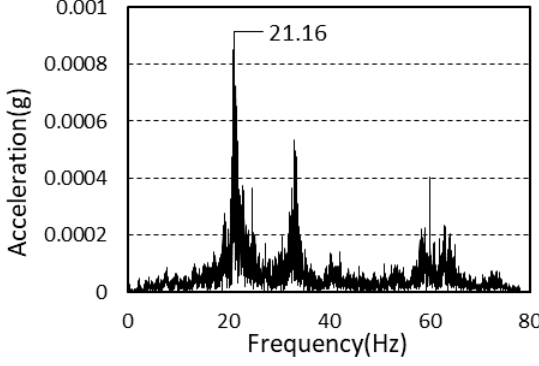
Figure 10. Power spectrum (framing completion).